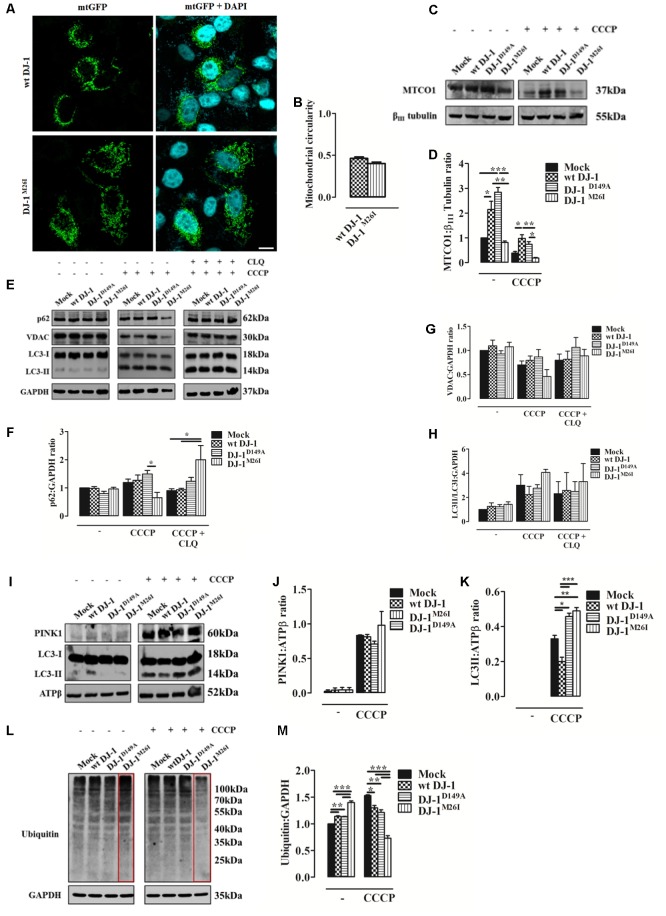
Loss of the DJ-1/SUMO interaction deregulates cellular mitophagy. (A) Analysis of mitochondrial morphology in SH-SY5Y cells expressing the FLAG-DJ-1M26I construct with quantification in (B) [mitochondrial circularity, wt DJ-1: 0.46 ± 0.02, DJ-1M26I: 0.40 ± 0.02; results are shown as mean ± SEM (n = 3; no variance was observed)]. Scale bar = 10 μm. (C) Immunoblotting analysis of mitochondrial DNA (mtDNA) encoded protein MTCO-1 content after CCCP treatment (8 h, 10 μM) in SH-SY5Y cells co-transfected with wt FLAG-DJ-1, FLAG-DJ-1D149A, or FLAG-DJ-1M26I constructs 24 h after transfection. Data, quantified in (D), are shown as mean ± SEM (n = 3; ∗∗∗p < 0.001; ∗∗0.001 < p < 0.01; ∗0.01 < p < 0.05) [MTCO-1 density relative to βIII tubulin, untreated Mock: 1.00 ± 0.00, wt DJ-1: 2.15 ± 0.33, DJ-1D149A: 2.84 ± 0.19, DJ-1M26I: 0.81 ± 0.06; 8 h CCCP 10 μM Mock: 0.39 ± 0.06, wt DJ-1: 0.98 ± 0.14, DJ-1D149A: 0.74 ± 0.10, DJ-1M26I: 0.18 ± 0.02]. (E–H) Total extracts were then analyzed by Western blotting, testing LC3 degree of activation, p62, and VDAC before and after treatment with chloroquine (CLQ) (8 h, 1:1000) (E). Data were normalized on the basis of GAPDH levels and quantified in F–H [p62 density, untreated Mock: 1 ± 0.00, wt DJ-1: 0.99 ± 0.06, DJ-1D149A: 0.80 ± 0.09, DJ-1M26I: 0.96 ± 0.06; 8 h CCCP 10 μM Mock: 1.19 ± 0.12, wt DJ-1: 1.27 ± 0.19, DJ-1D149A: 1.49 ± 0.13, DJ-1M26I: 0.65 ± 0.18; 8 h CCCP 10 μM + 8 h CLQ 1:1000 Mock: 0.90 ± 0.07, wt DJ-1: 0.94 ± 0.05, DJ-1D149A: 1.24 ± 0.14, DJ-1M26I: 2.00 ± 0.51; (n = 5; ∗0.01 < p < 0.05); VDAC density, untreated Mock: 1 ± 0.00, wt DJ-1: 1.10 ± 0.12, DJ-1D149A: 0.93 ± 0.07, DJ-1M26I: 1.08 ± 0.09; 8 h CCCP 10 μM Mock: 0.70 ± 0.08, wt DJ-1: 0.80 ± 0.09, DJ-1D149A: 0.87 ± 0.15, DJ-1M26I: 0.46 ± 0.14; 8 h CCCP 10 μM + 8 h CLQ 1:1000 Mock: 0.80 ± 0.13, wt DJ-1: 0.82 ± 0.17, DJ-1D149A: 1.06 ± 0.20, DJ-1M26I: 0.89 ± 0.13 (5 < n < 8, no variance was observed); LC3II/LC3I density, untreated Mock: 1 ± 0.00, wt DJ-1:1.26 ± 0.29, DJ-1D149A: 1.23 ± 0.18, DJ-1M26I: 1.43 ± 0.21; 8 h CCCP 10 μM Mock: 3.01 ± 0.87, wt DJ-1: 2.23 ± 0.69, DJ-1D149A: 2.76 ± 0.29, DJ-1M26I: 4.07 ± 0.26; 8 h CCCP 10 μM + 8 h CLQ 1:1000 Mock: 2.31 ± 1.01, wt DJ-1: 2.57 ± 1.48, DJ-1D149A: 2.49 ± 0.81, DJ-1M26I: 3.31 ± 1.49 (3 < n < 7, no variance was observed)]. Data are shown as mean ± SEM. (I–K) Mitochondrial extracts were analyzed by Western blotting using the following antibodies: anti-PINK1, anti-LC3, and anti-ATPβ (loading control). The graph represents the quantification of PINK1 (J) [PINK1 density, untreated Mock: 0.04 ± 0.03, wt DJ-1: 0.04 ± 0.03, DJ-1D149A: 0.04 ± 0.04, DJ-1M26I: 0.04 ± 0.03; 8 h CCCP 10 μM Mock: 0.83 ± 0.01, wt DJ-1: 0.81 ± 0.04, DJ-1D149A: 0.71 ± 0.04, DJ-1M26I: 0.98 ± 0.20 (3 < n < 5; no variance was observed)], and LC3 (K) expression [LC3II density, 8 h CCCP 10 μM Mock: 0.33 ± 0.02, wt DJ-1: 0.20 ± 0.02, DJ-1D149A: 0.46 ± 0.02, DJ-1M26I: 0.49 ± 0.02 (n = 3; ∗∗∗p < 0.001; ∗∗0.001 < p < 0.01; ∗0.01 < p < 0.05)]. Data are shown as mean ± SEM. In panel (L) a representative Western blot on protein ubiquitination is shown and quantified in the corresponding graph (M) normalized to GAPDH levels [ubiquitination density, untreated Mock: 1 ± 0.00, wt DJ-1: 1.14 ± 0.01, DJ-1D149A: 1.13 ± 0.01, DJ-1M26I: 1.40 ± 0.03; 8 h CCCP 10 μM Mock: 1.53 ± 0.01, wt DJ-1: 1.30 ± 0.05, DJ-1D149A: 1.21 ± 0.05, DJ-1M26I: 0.73 ± 0.05; data are shown as mean ± SEM (n = 3; ∗∗∗p < 0.001; ∗∗0.001 < p < 0.01; ∗0.01 < p < 0.05).